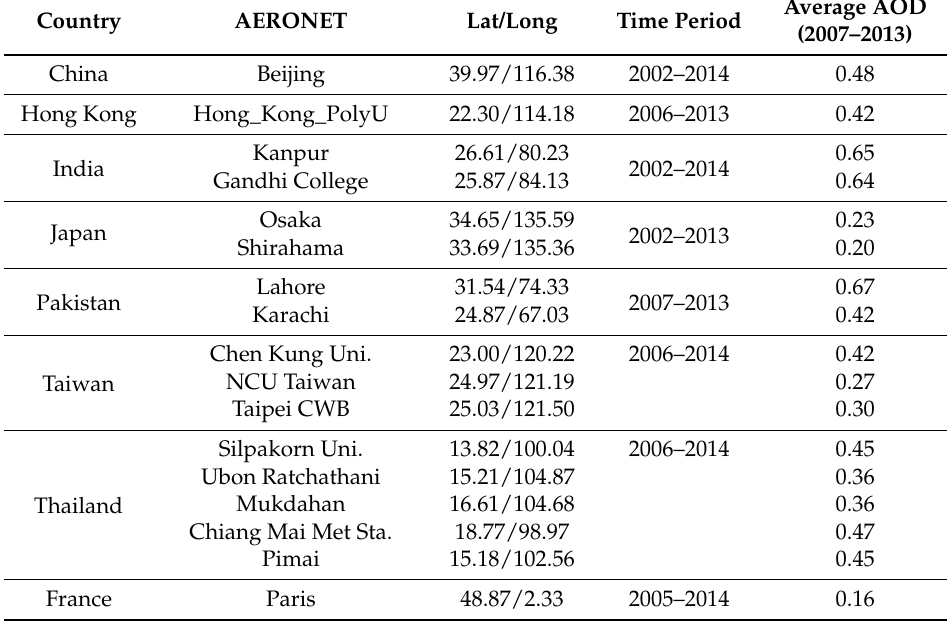
Table 1. AErosol RObotic NETwork (AERONET) Level 2.0 data used in this